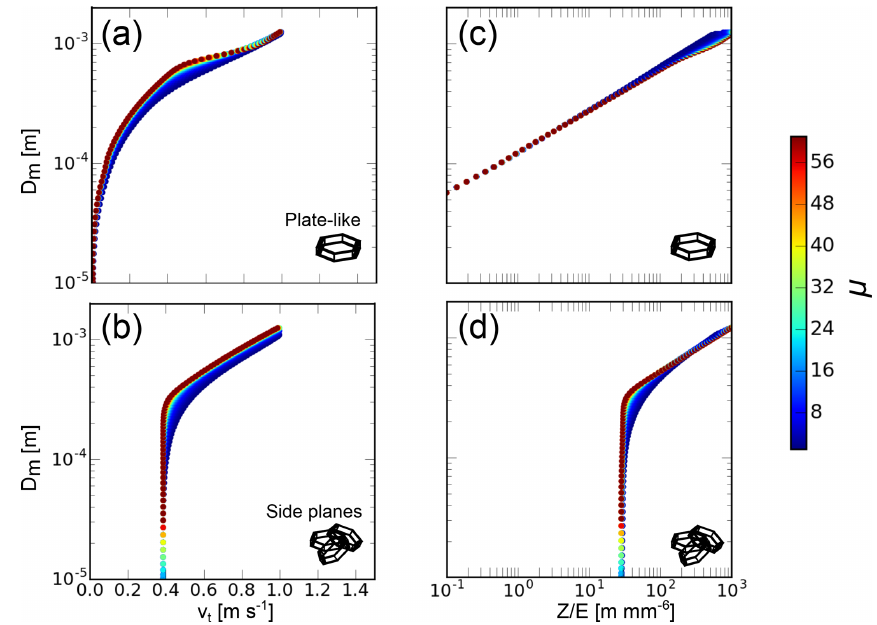
Figure 5. Relationship of v t with D (a, b) and Z/E with D (c, d) for the particle types plate-like (a, c) and side planes (b, d) . v t graphs are all plotted for p = 650hPa and T = 255K. See Tables A2 and A1 for the particle properties. Table 2. Ratios between the results of the original and the disturbed retrieval. The row labeled mean gives the original input parameters, and the row labeled error is the range that has been used for